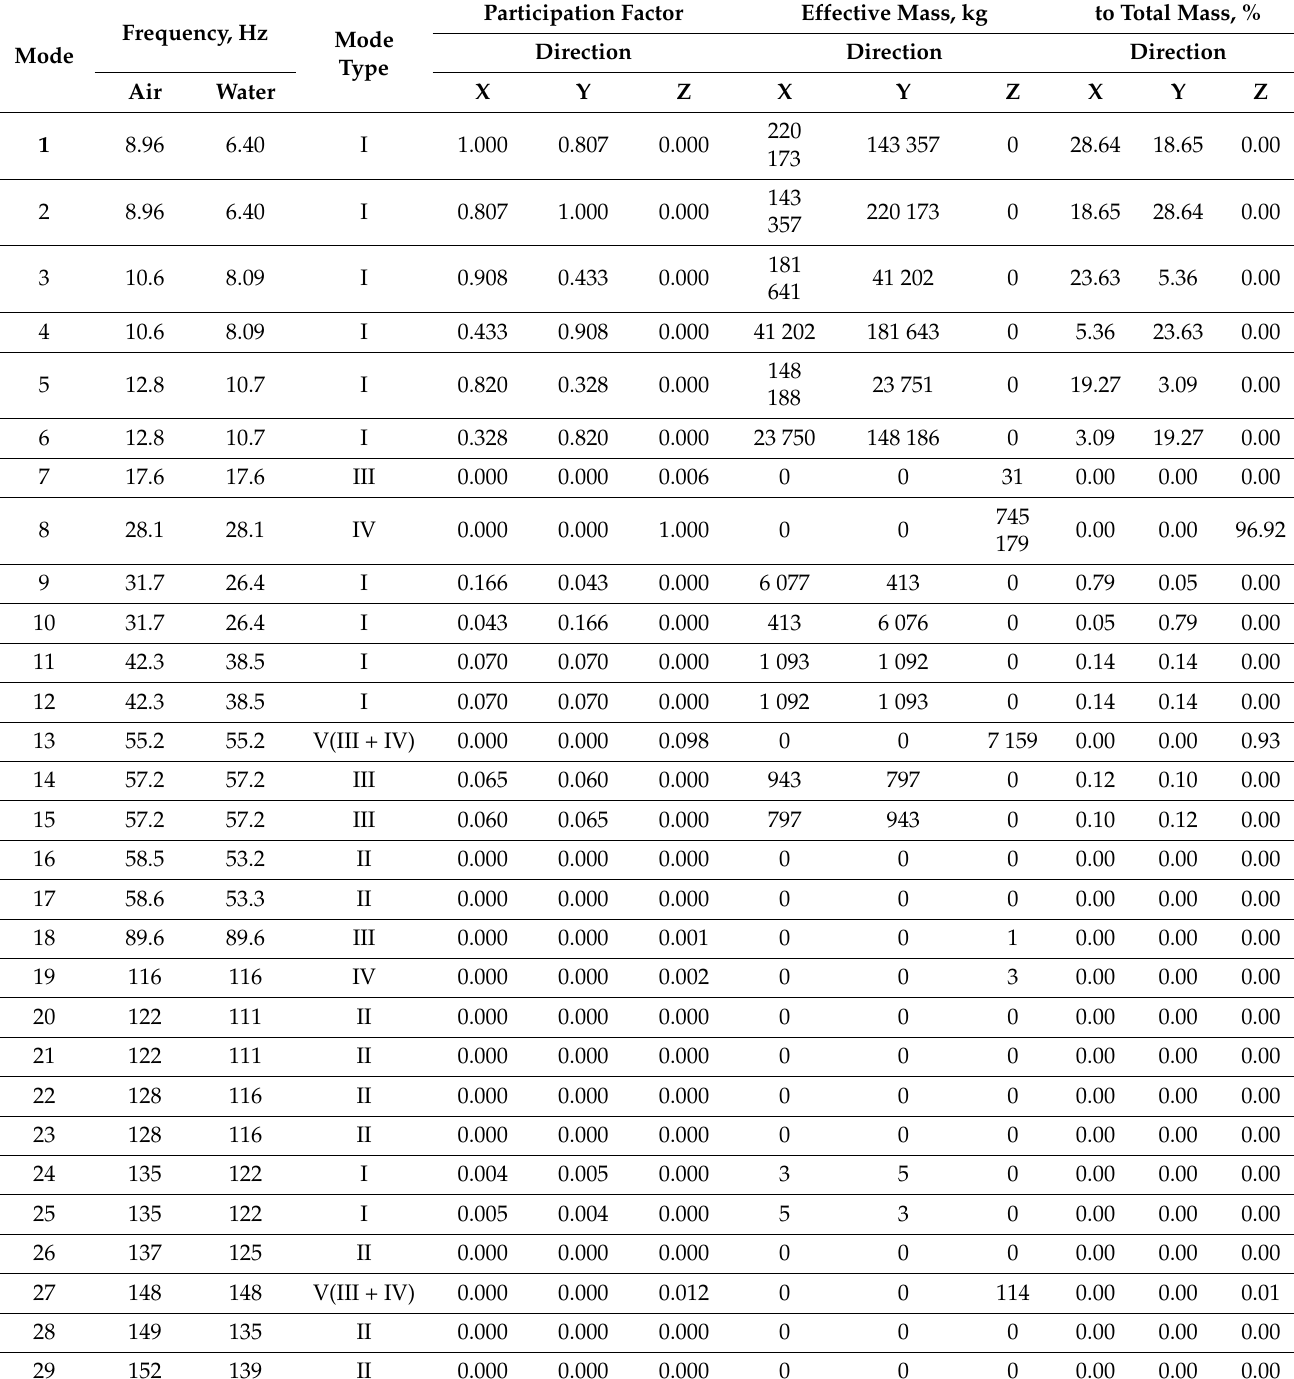
Table 1. The eigenfrequencies and dynamic parameters for the defect-free